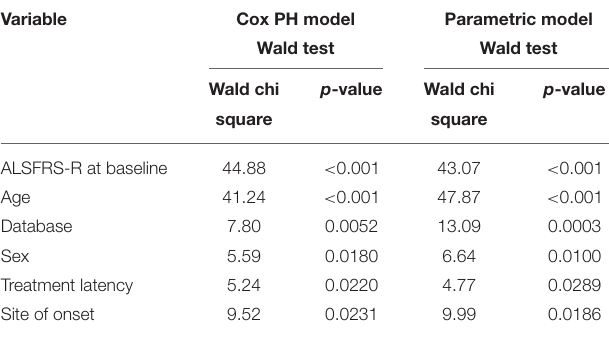
TABLE 2 | Adjusted Cox proportional hazard fit and parametric survival analyses with available riluzole- and placebo-treated PRO-ACT patients.